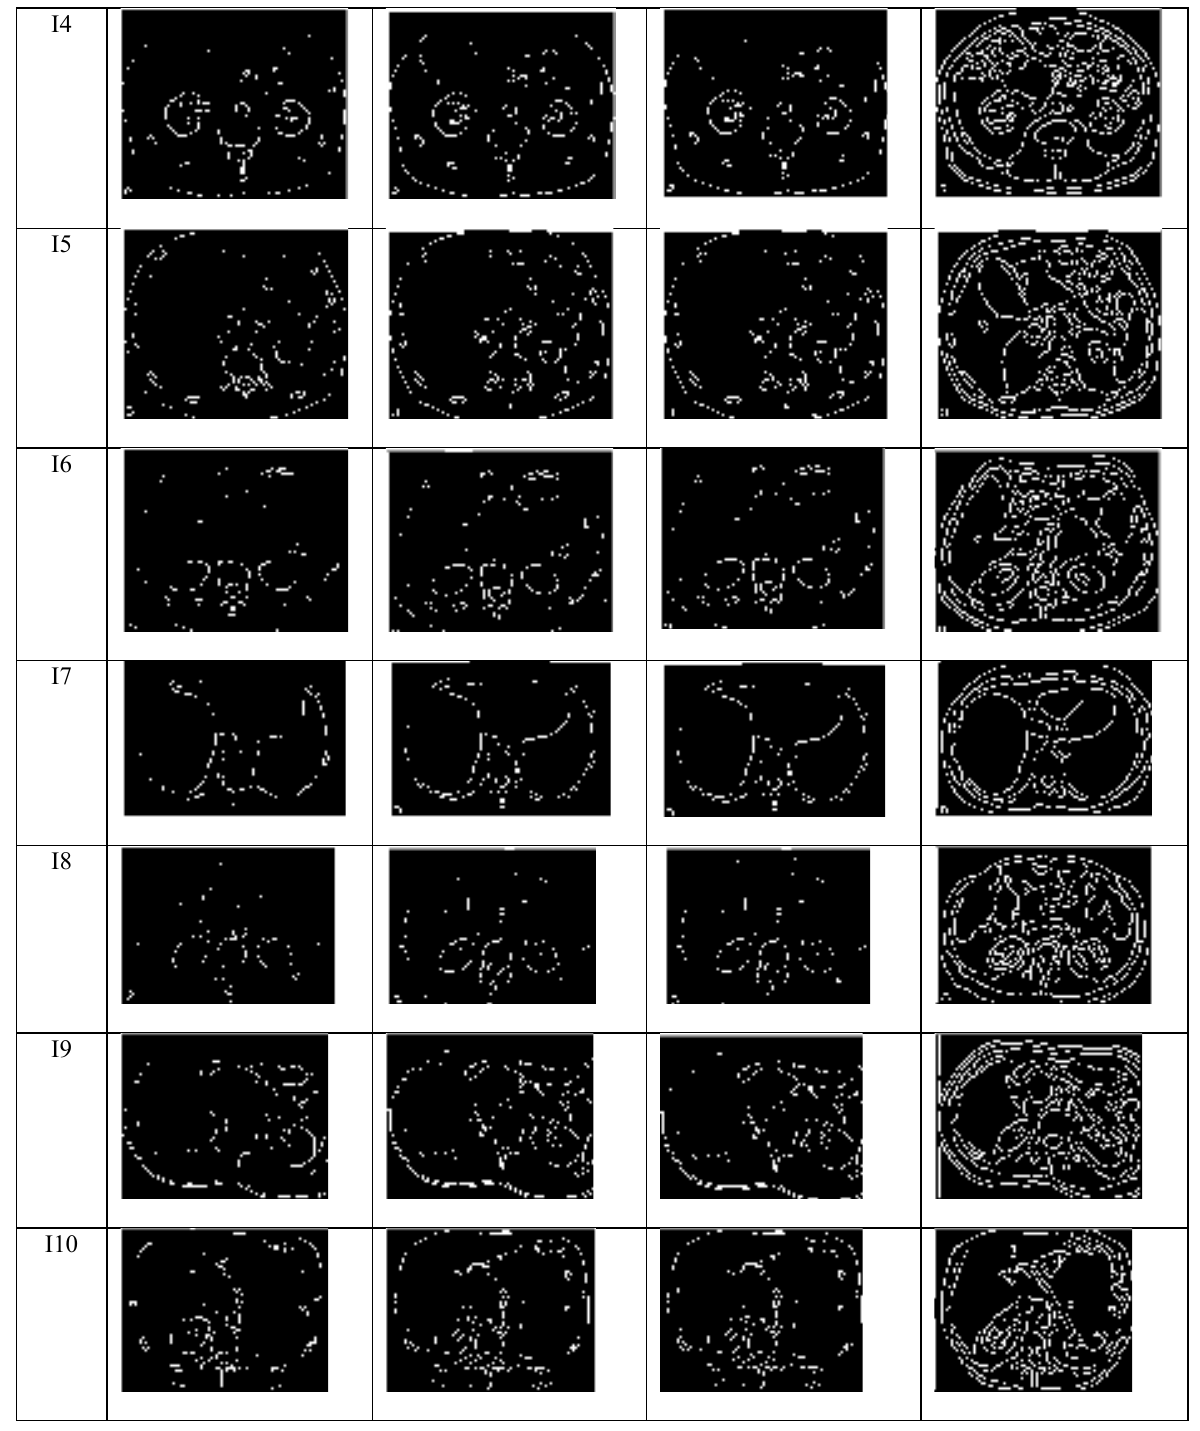
Figure 9. CT Images after Classical Image Segmentation (Prewitt, Roberts, Sobel and Canny Edge